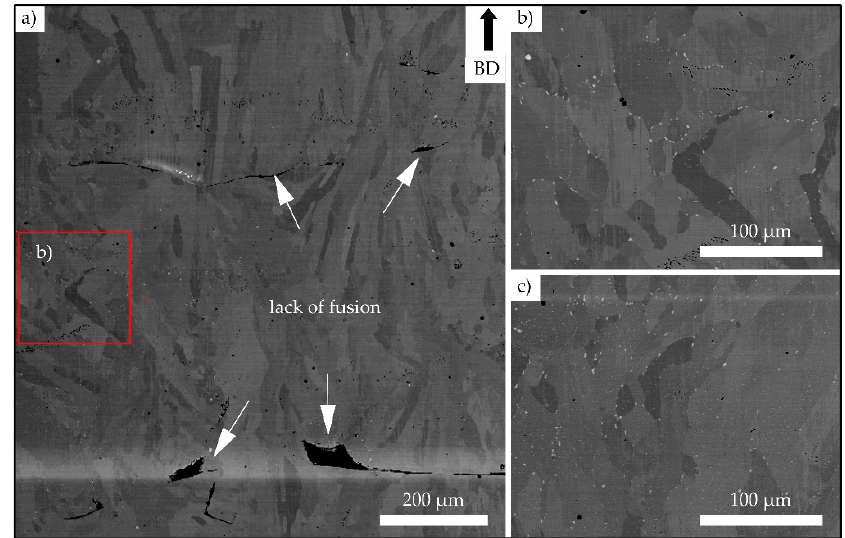
Figure 2. Backscatter electron (BSE) images of the lower half of one strut with a 3 mm diameter after initial testing. ( a ) Overview detailing the microstructure within an area from the left strut surface to the center line of the strut; ( b ) the area marked red in ( a ) at higher magnification; and ( c ) a specimen region below the area visible in ( a ) for reference.